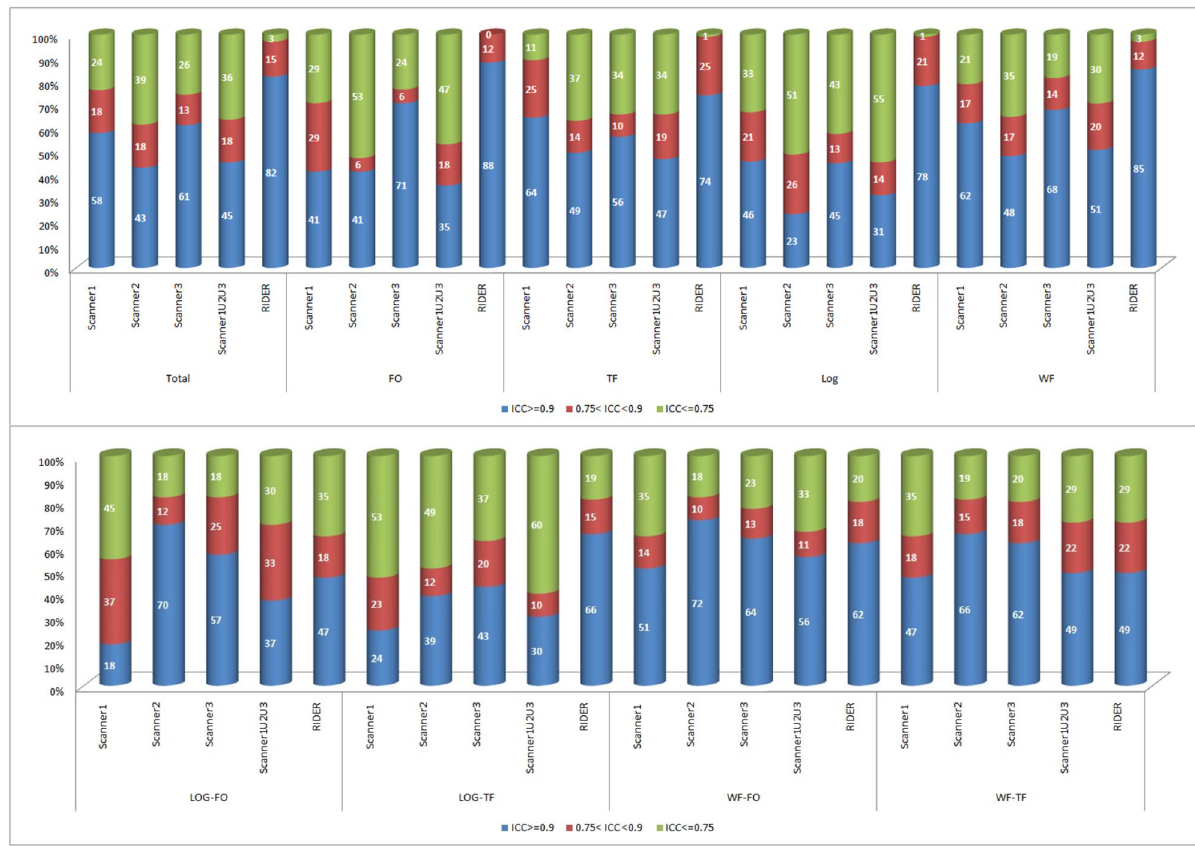
Figure 1. Repeatability analysis using repeated phantom scans for all the different radiomic feature classes. The median ICC values for all the 6 protocols is reported, separately for scanner1, scanner2, scanner3 and the union of the three. Repeatability analysis on RIDER (clinical cohort) was also performed. Three different levels of repeatability are defined: good (ICC ≥ 0.9), medium (0.75 < ICC < 0.9), and poor (ICC ≤ 0.75) (FO = First Order Feature; TF = Textural Feature; LOG = Total LoG Feature; WF = Total Wavelet Feature; LOG-FO = LoG First Order Feature; LOG-TF = LoG Textural Feature; WF-FO = Wavelet First Order Feature; WF-TF = Wavelet Textural